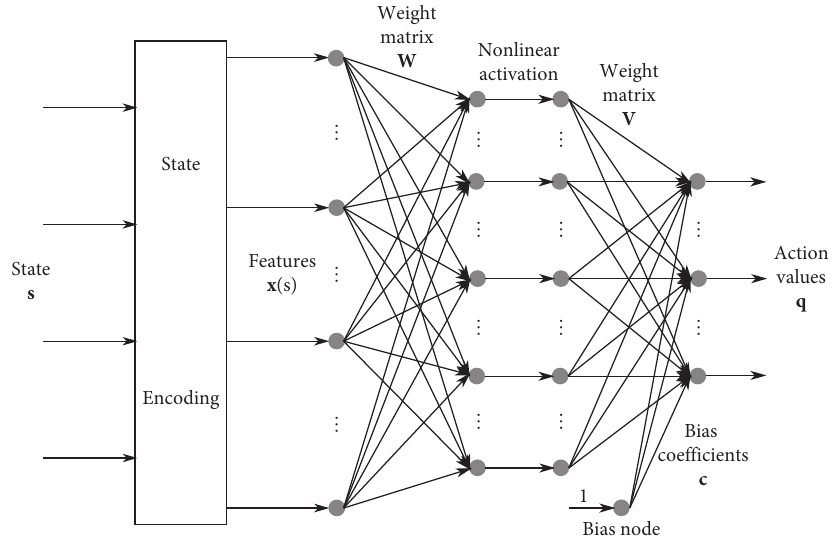
Figure 2: Structure of the artificial neural network that serves as the approximate value